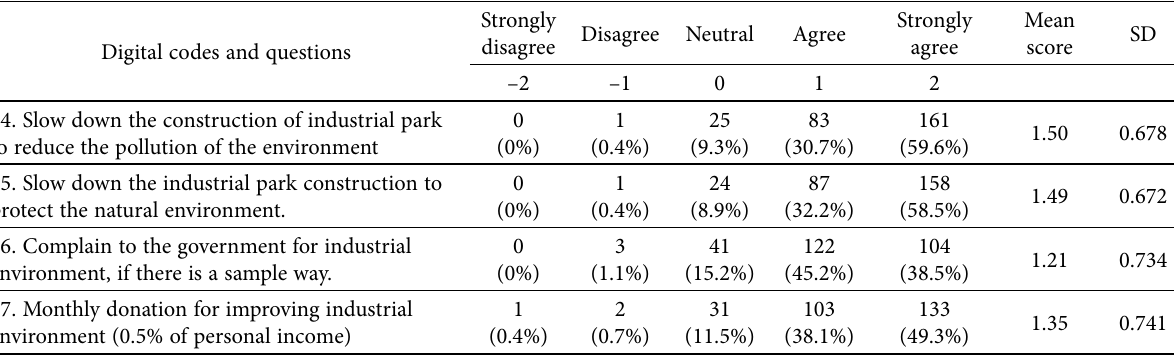
Table 3. Interviewees’ evaluation of development and policy